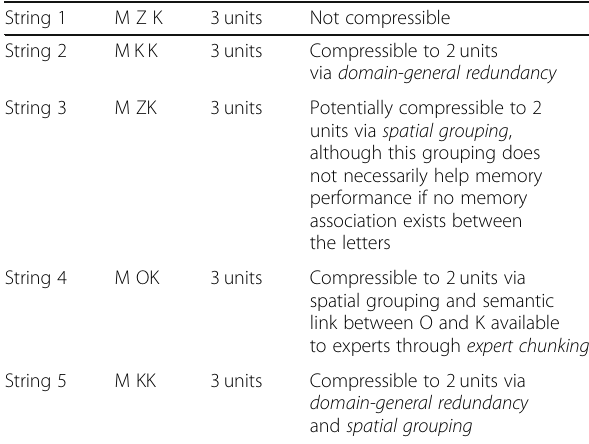
Table 1 Ways to chunk visually presented information. Letter identities can represent different colors, shapes,